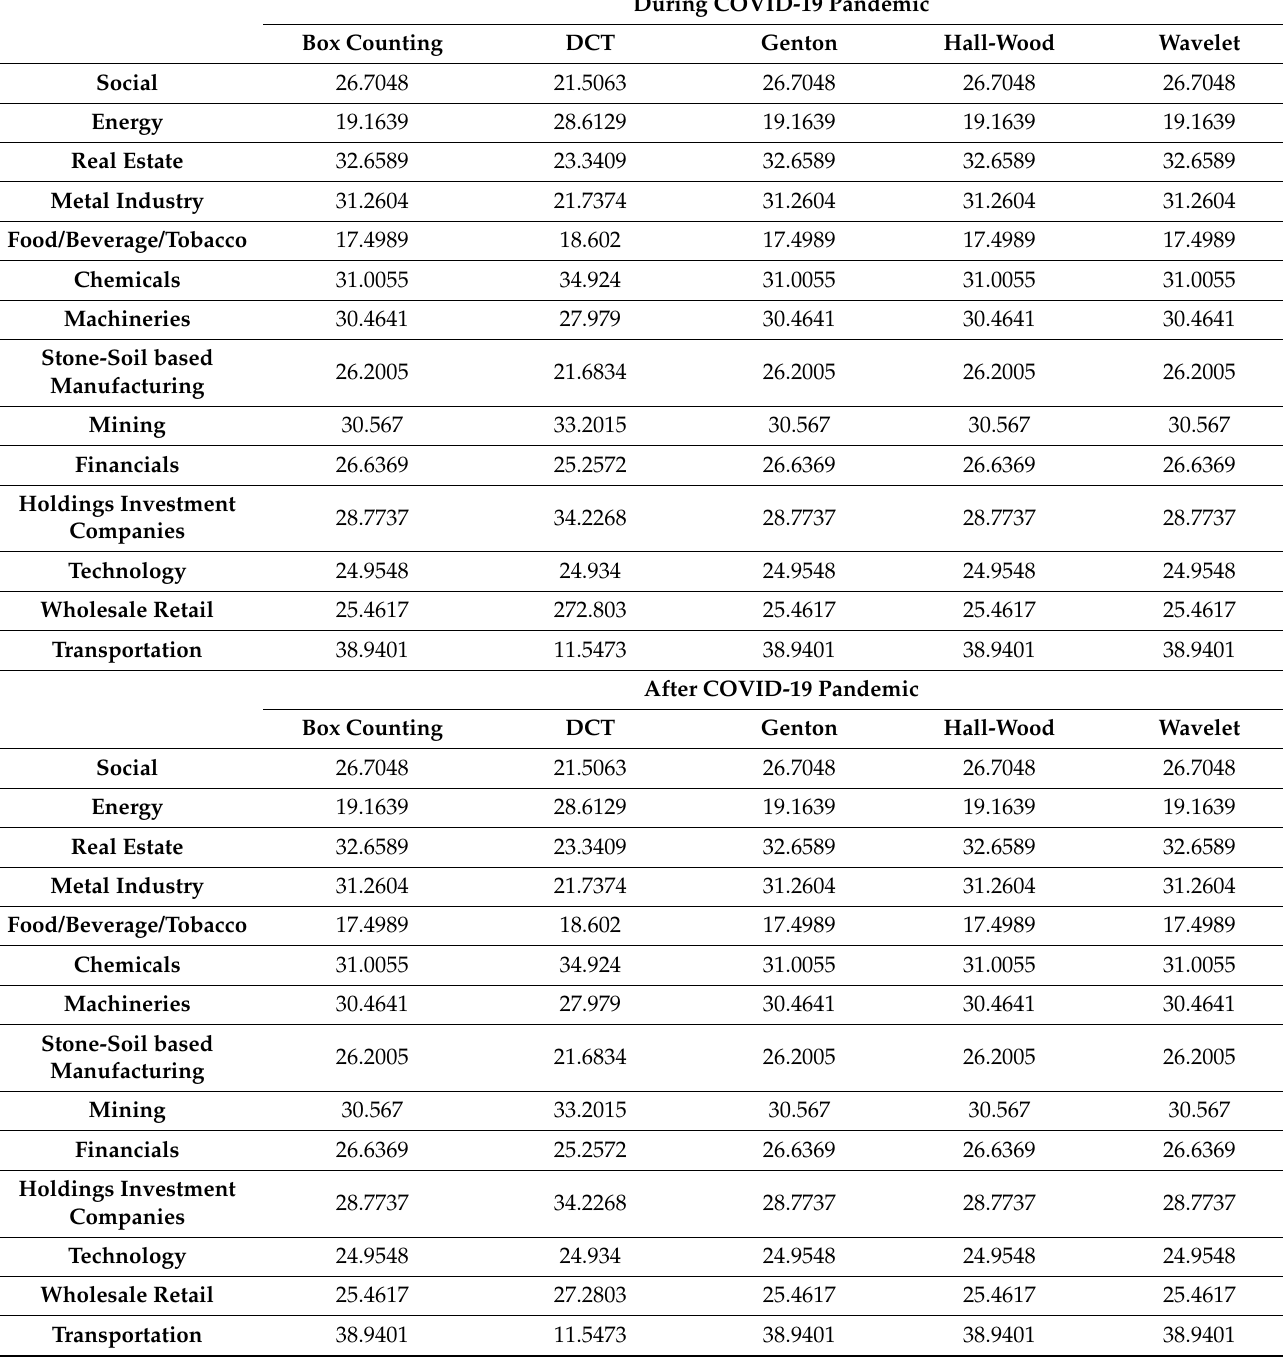
Table A15. Means of inter-sectorial DTW similarities regarding daily fractal dimension